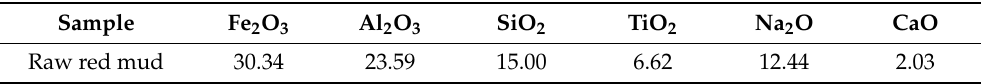
Figure 2. XRD pattern of the raw red mud. Table 1. The chemical composition of raw red mud